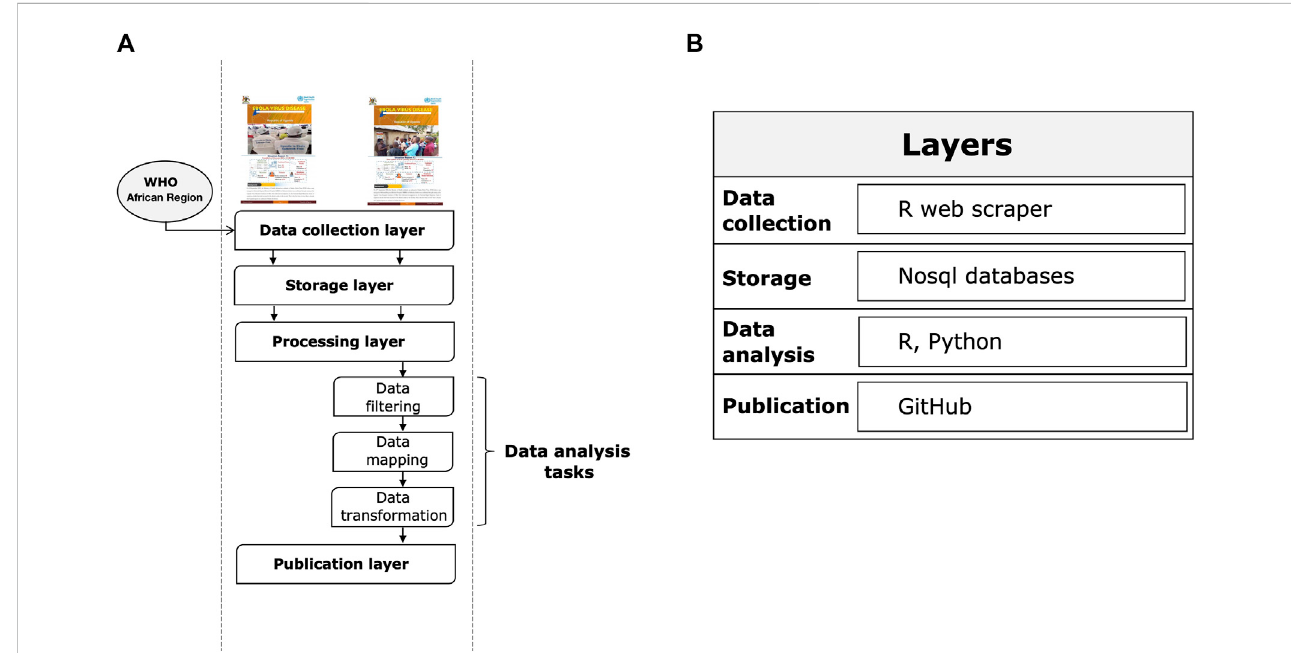
FIGURE 1 Layers of the Ebola information management system. (A) System execution fl ow. (B) Reference